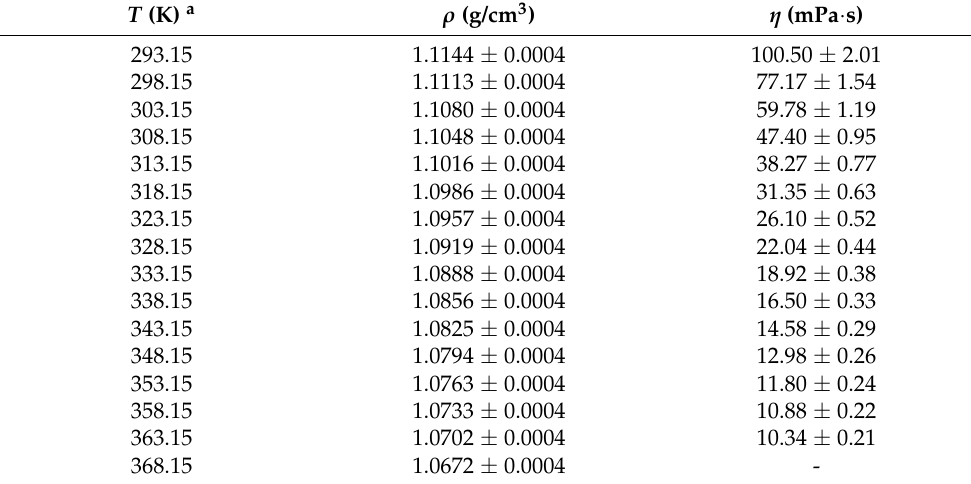
Table 1. Experimental densities ( ρ ) as well as dynamic viscosities ( η ) of ChCl:AA (1:2) at atmo- spheric